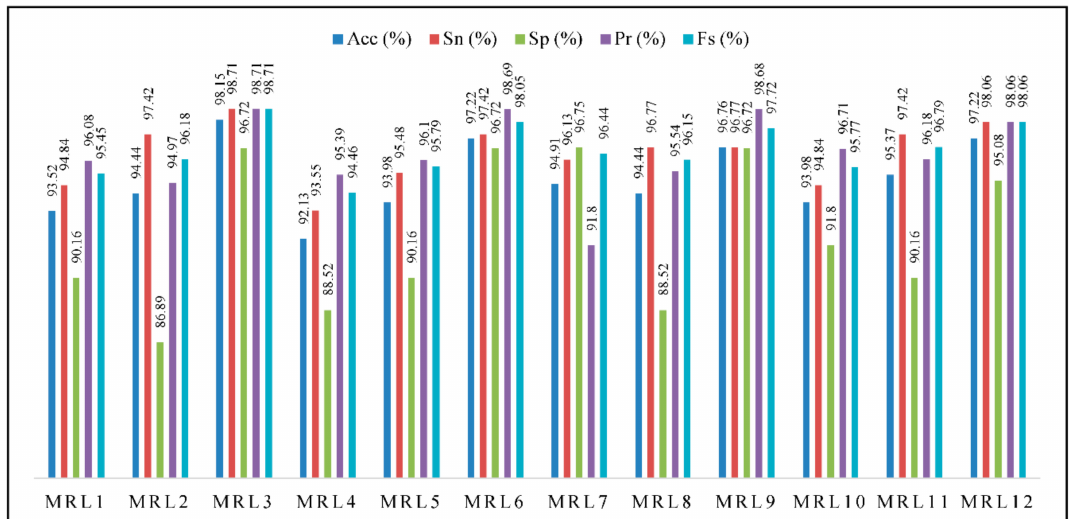
Figure 16. Results of SVM using geometric and MRL features ( MRL 1 : MRL 0 , MRL 2 : GF_MRL 0 , MRL 3 :